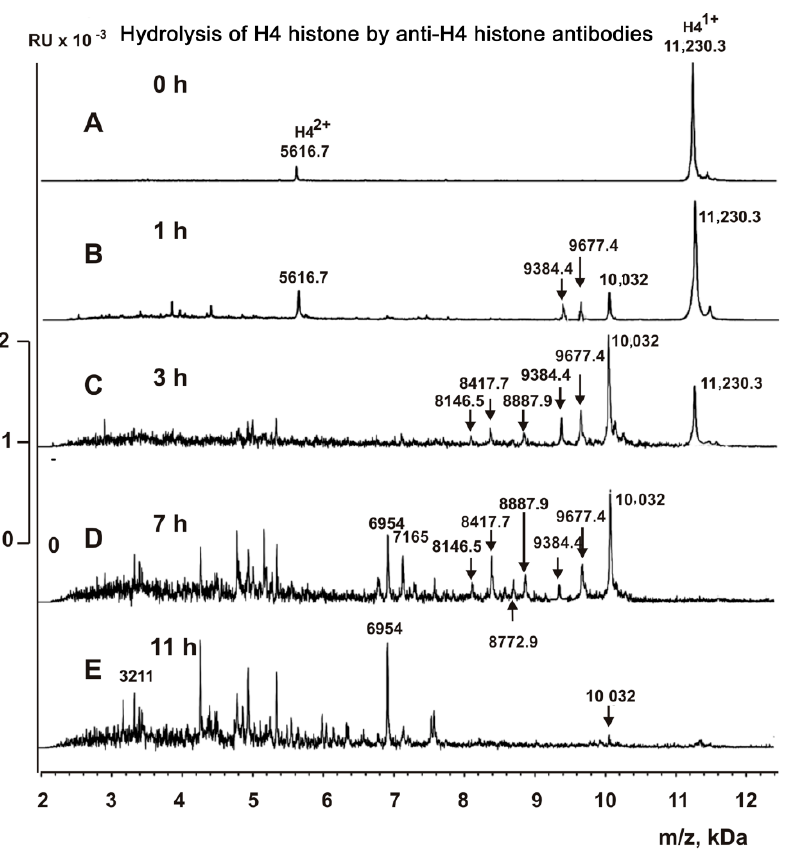
Figure 6. MALDI spectra ( A – E ) corresponding to H4 histone (1.0 mg/mL) over time hydrolysis (0–24 h) by anti-H4 IgGs (5 µg/mL).